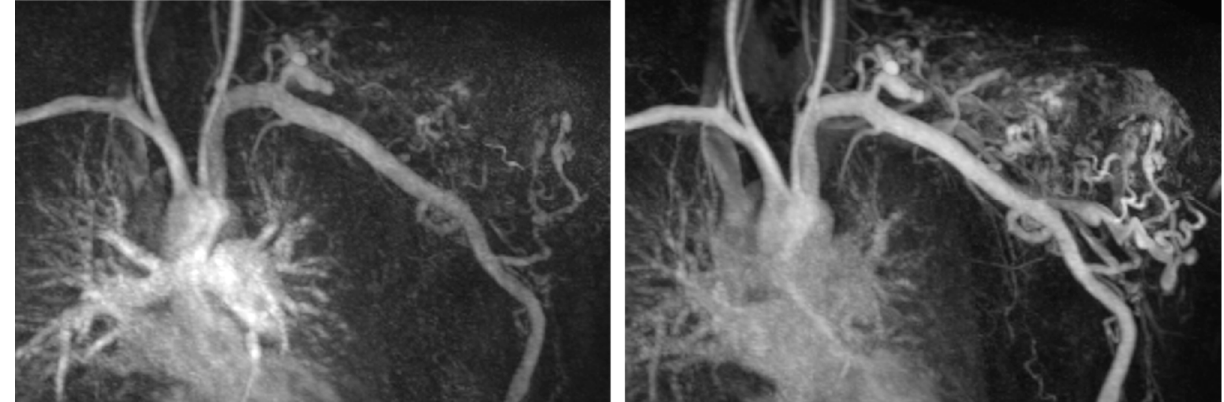
Figure 2. MRI TWIST-angiography of a patient with an AVM of the left shoulder highlighting the fast-flow conditions within the AVM.